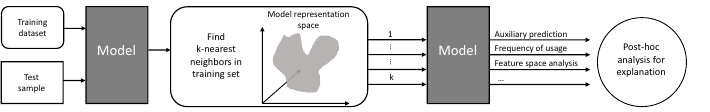
Figure 4. Explaining inaccurate predictions by k-nearest neighbors pipeline (adapted and extended from [40]). After identifying the k-nearest neighbors in the model representation space, we analyze the auxiliary predictions based on the nearest neighbors regarding the accuracy, relevance, and distance to the test sample in the feature